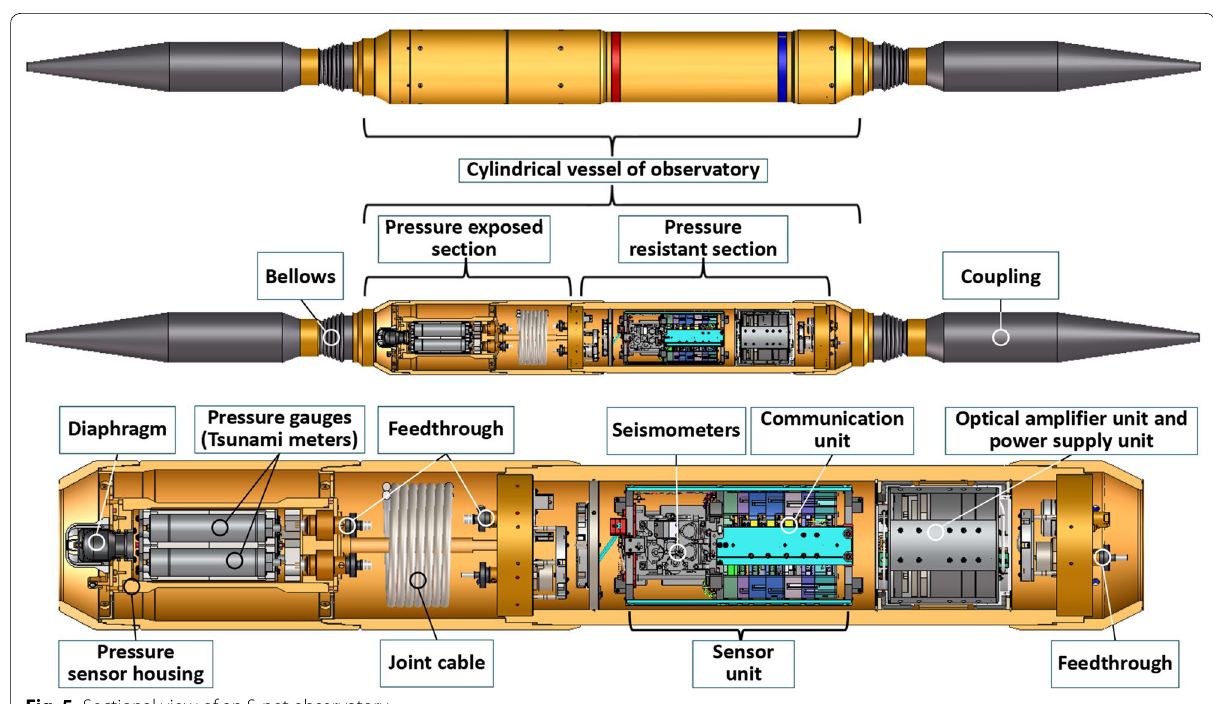
Fig. 5 Sectional view of an S-net